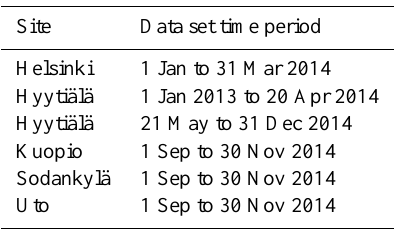
Table 2. Measurement site locations and data set time periods in- cluded in this